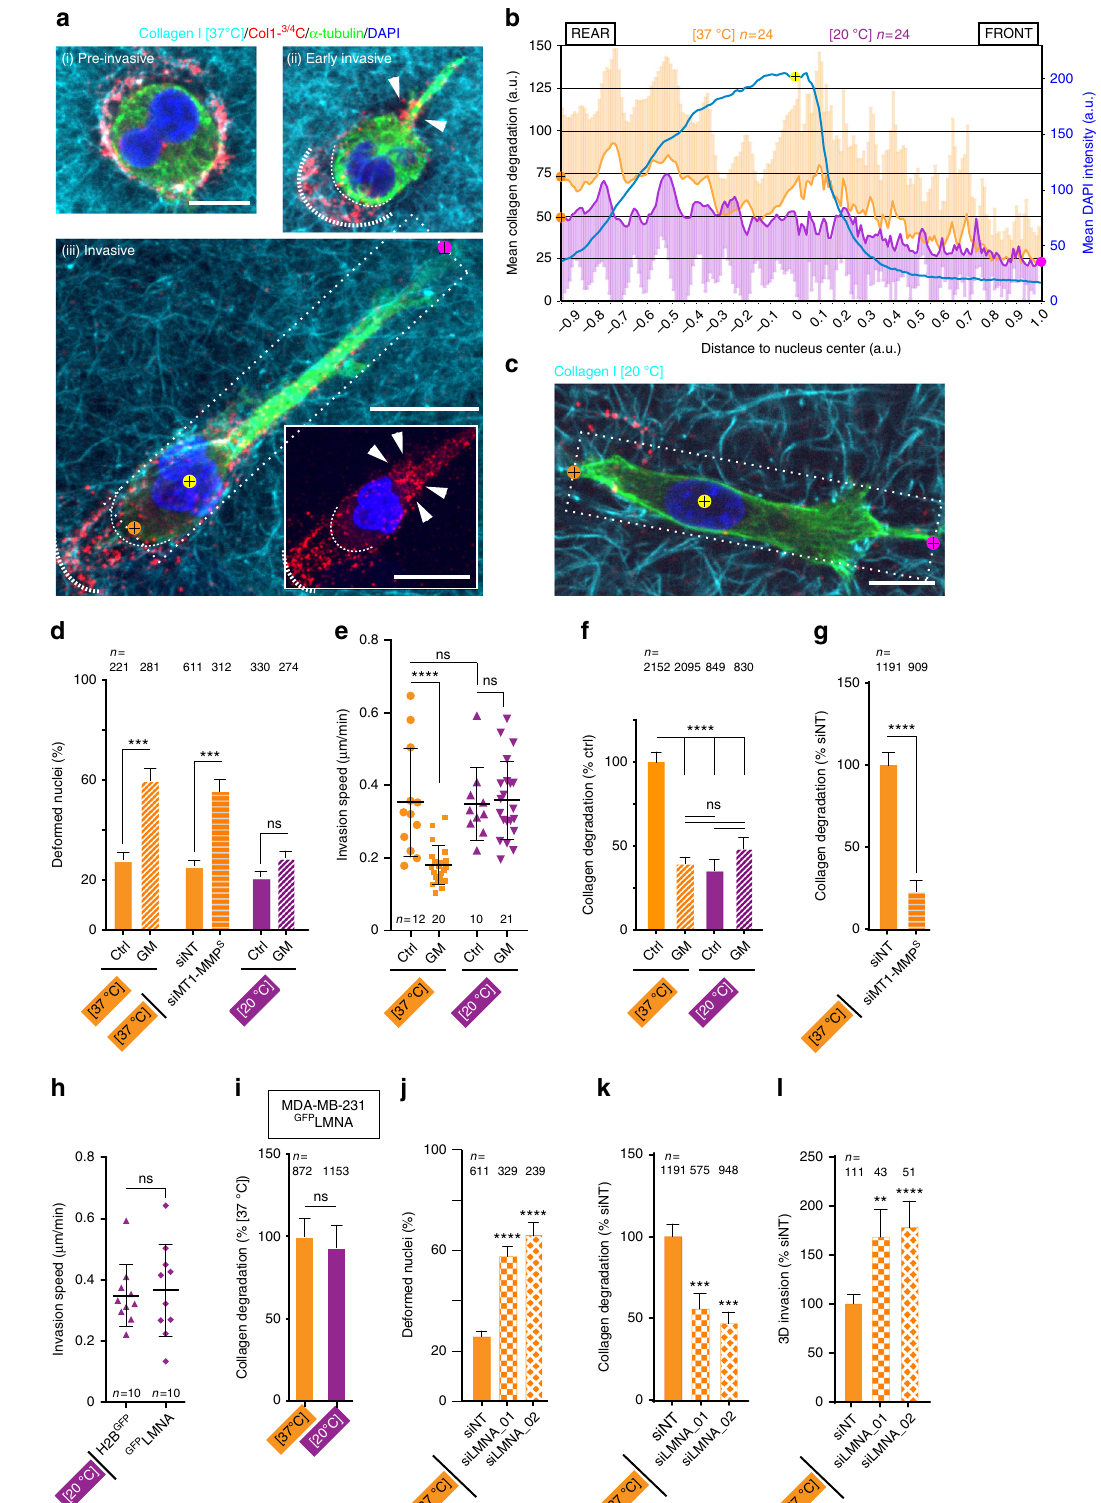
(Fig. 1f), collagenolysis levels of GFP LMNA-overexpressing cells remained elevated in large, as compared to small, pore size collagen environment (Fig. 1i and Supplementary Fig. 2g). These observations revealed a relationship between